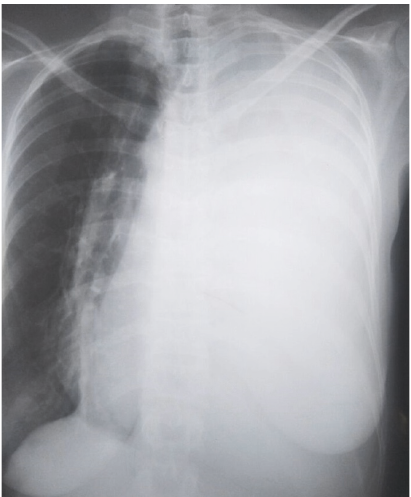
Figure 1: Posteroanterior chest roentgenogram showing a homoge- neous opacity taking the whole hemi thoracic left field and pushing the mediastinum towards the contralateral